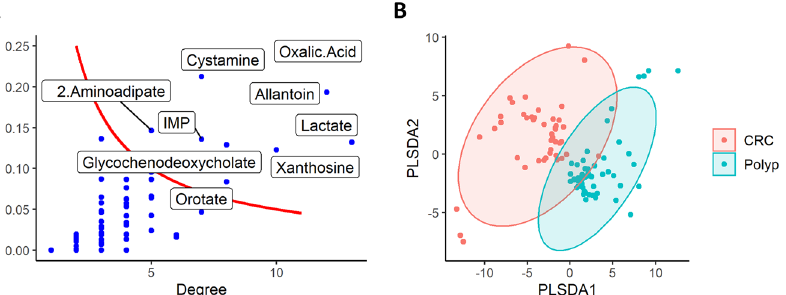
Figure 4: In panel (A), the importance of nodes preserved in the differential network’s backbone between CRC and polyp subjects, characterized by betweenness centrality (Btw, y -axis) and node degree ( x -axis). Key nodes with high degrees and high betweenness (degree ∗ betweenness > 0.5) were labelled with their metabolite names. In panel (B), scores plot of PLS-DA classification model between CRC subjects and polyp